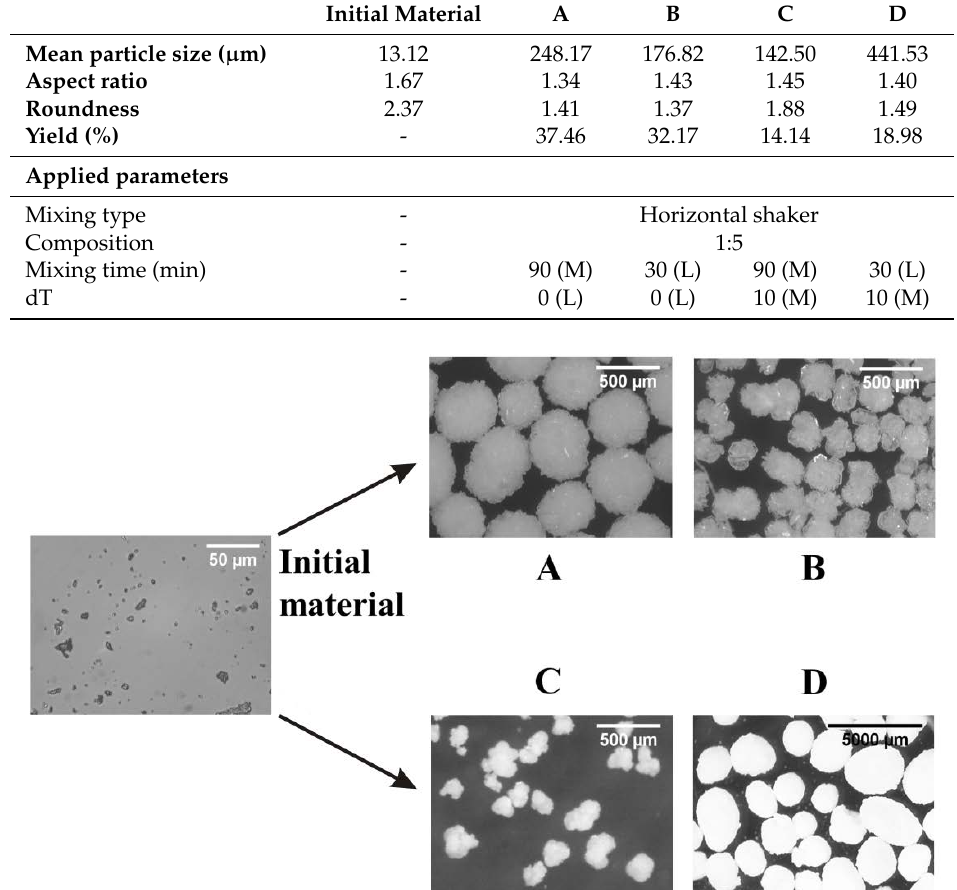
Figure 8. Light microscopy measurements of the initial material and the SA products produced with the application of different process parameters. ( A ) Light microscopic image of product SA (A); ( B) light microscopic image of product SA (B); ( C ) light microscopic image of product SA (C); ( D ) light microscopic image of product SA (D). Process parameters are in Table 6.